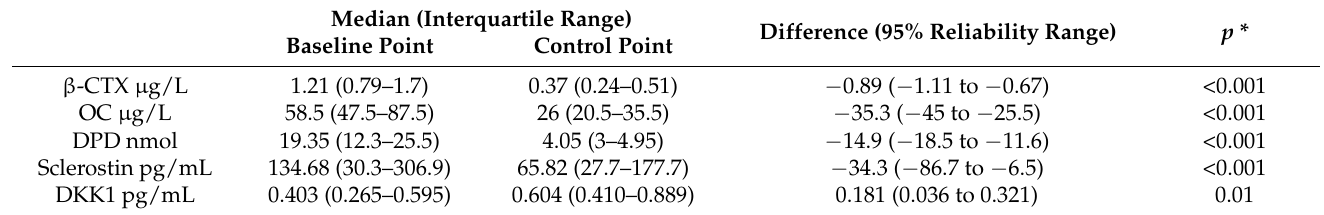
Table 3. Changes in bone remodeling markers and Wnt inhibitors after one year of ATD treatment. Median (Interquartile